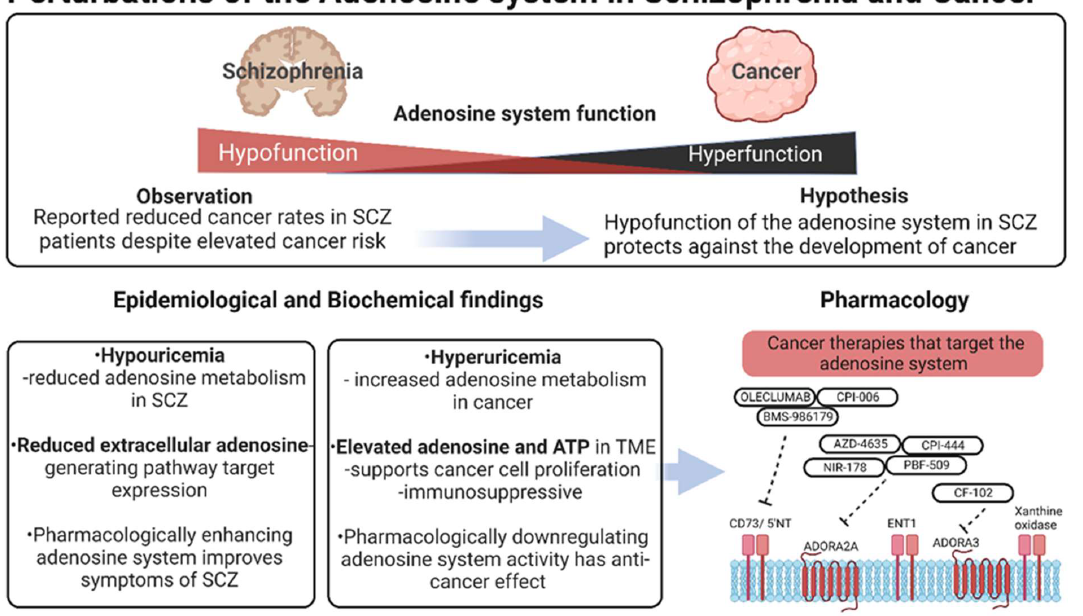
Figure 1. Perturbations of the adenosine system in schizophrenia and cancer. Overview of the population and biochemical evidence for perturbed adenosine system function in schizophrenia and cancer. Reduced cancer rates in schizophrenia patients despite elevated cancer risk implies some underlying biochemical protective mechanism. Reduced extracellular adenosine availability, and hypouricemia observed in these patients may explain the reduced cancer rates. Generated in Biorender.